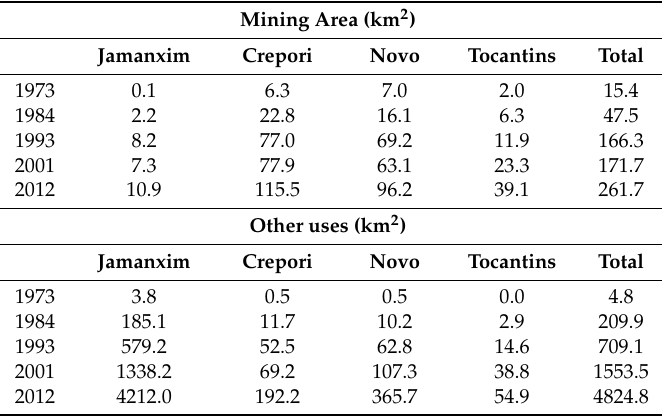
Figure 9. Map of the ASGM expansion (1973, 1984, 1993, 2001, and 2012) in the area of study. Note that the expansion occured during different periods at different regions: for Cuiú-cuiú area ( a ) encountered the highest expansion occured until 1984; for the Surubim area ( b ), most of the expansion happened between 1984 and 1993; and for the Tocantinzinho area ( c ) the expansion is more prominent between 1993 and 2012. Other land uses in 2012 are also plotted in dark gray. * River network only displayed on ( a – c ). Table 3. Tabulation of historical ASGM and other uses not including mining for the four sub-basins of study: Crepori, Novo, Tocantins and